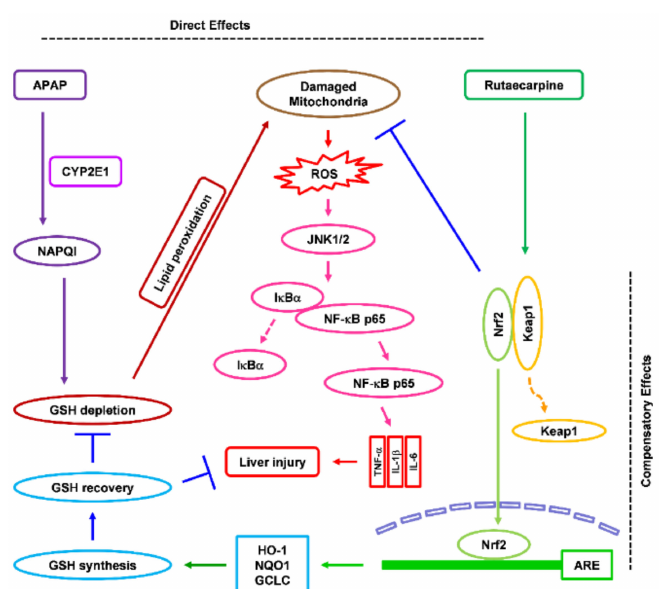
Figure 7. Protective effect of Rut in APAP-induced liver damage in mice. Direct effect. APAP is converted by CYP2E1 to NAPQI, a toxic metabolite. NAPQ1 depletes intracellular GSH and damages mitochondria by binding to mitochondrial proteins. Rut pretreatment inhibits the expression of CYP2E1, ameliorating intracellular GSH depletion, and inhibits lipid peroxidation, thereby prevent- ing APAP-mediated mitochondrial damage. Compensatory effect. Rut pretreatment increases the nuclear translocation of Nrf2 by alleviating its inhibition by Keap1, causing sustained activation of Nrf2 in the mouse liver. Prolonged activation of Nrf2 increases the GSH content in the mouse liver, eliminating NAPQI and protecting the liver against APAP-induced oxidative